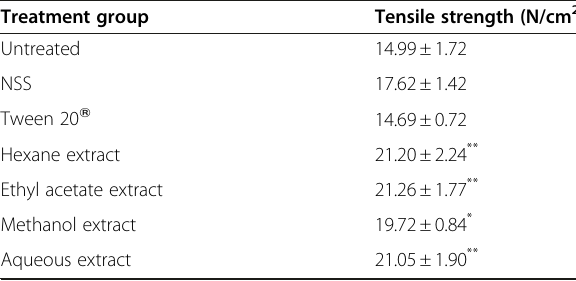
Table 1 Tensile strength of incision wounds treated with extracts of Centella asiatica on day 7 after wound infliction